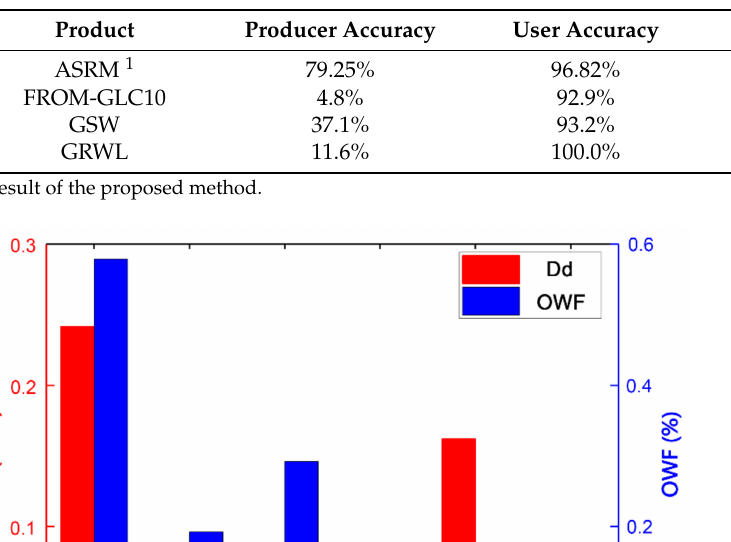
Table 3. Comparison of accuracy of various products.